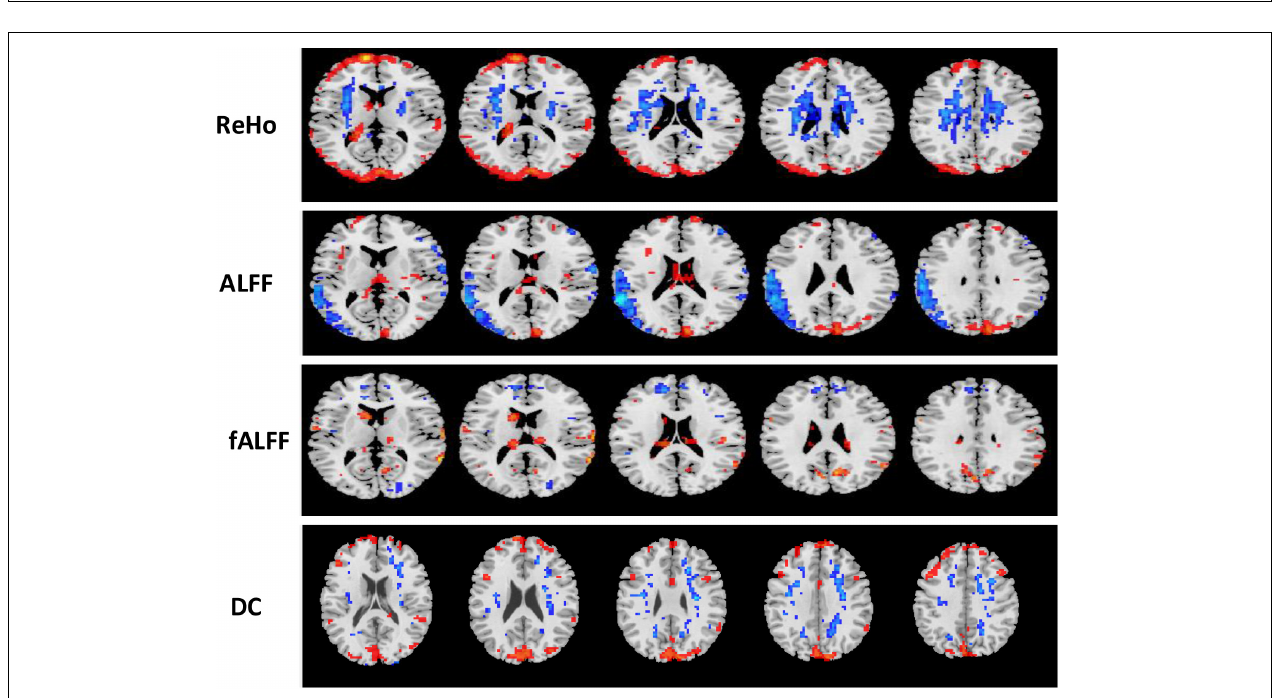
FIGURE 7 | Univariate t -test difference maps between two classification groups MCIs vs. MCIc, of four voxel maps.